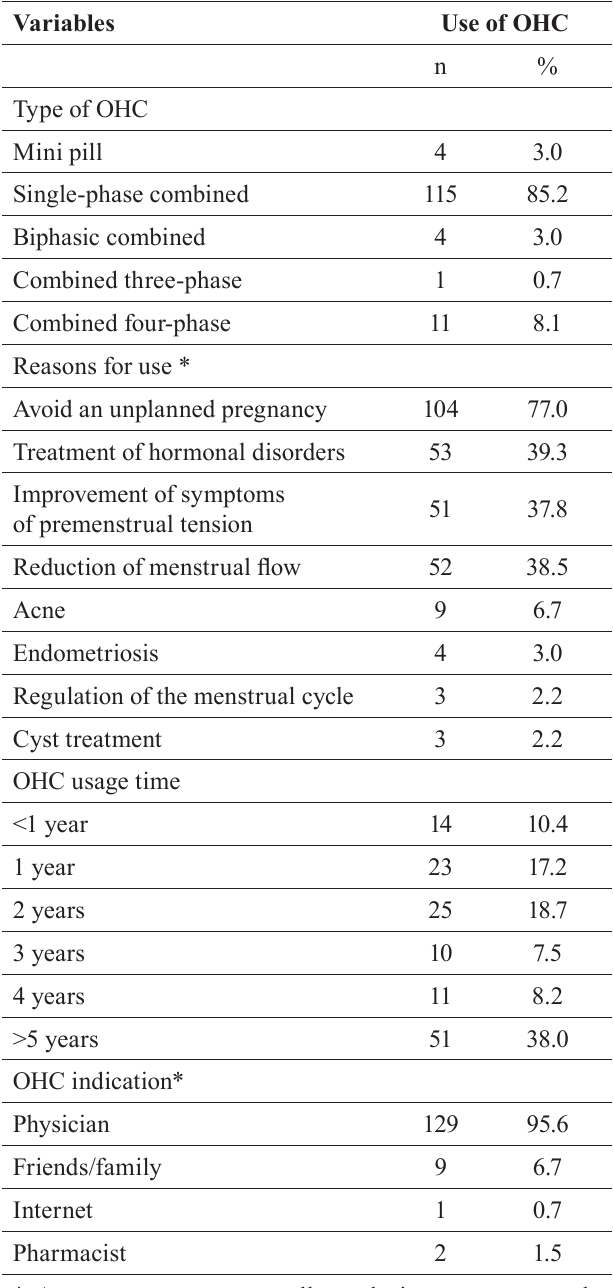
TABLE IV - Profile of adverse events related to the use of oral hormonal contraceptives among pharmacy students